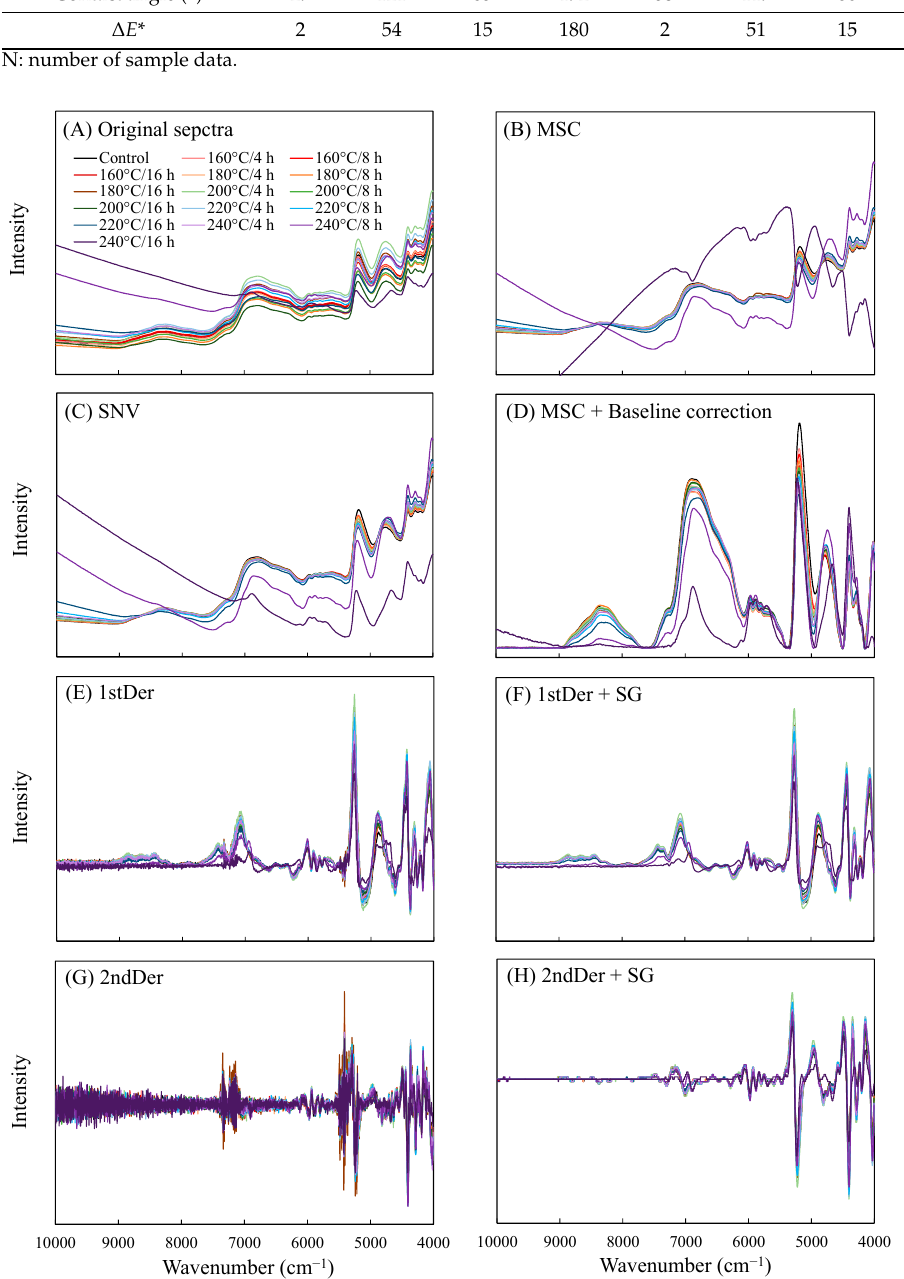
Figure 4. NIR spectra before ( A ) and after preprocessing by MSC ( B ), SNV ( C ), MSC + baseline correction ( D ), first derivative ( E ), first derivative + SG ( F ), second derivative ( G ), and second derivative + SG ( H ).